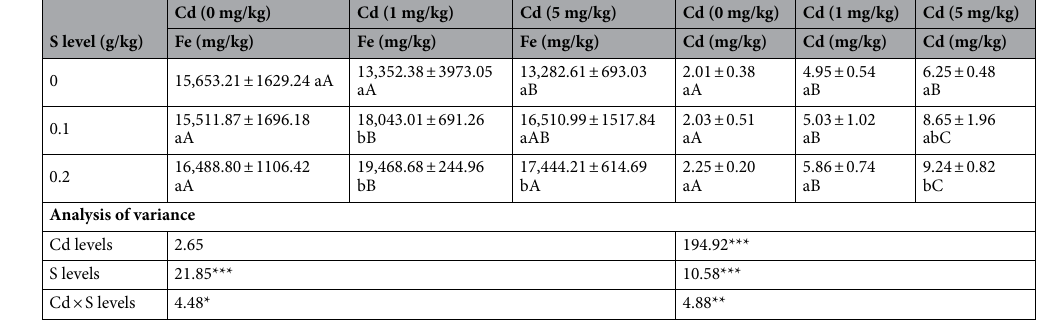
Table 2. The effect of sulfur application on ACA-extractable Fe and Cd concentration in rice iron plaque (mean ± S.E., n = 3). Different lowercase letters within Cd in root, stem, leaf, grain under the same Cd treatment indicates a significant difference among different S levels at P < 0.05. Different capital letters within Cd in root, stem, leaf, grain under the same S treatment indicates a significant difference among different Cd treatment at P < 0.05. Analysis of variance * P < 0.05, ** P < 0.01, *** P <